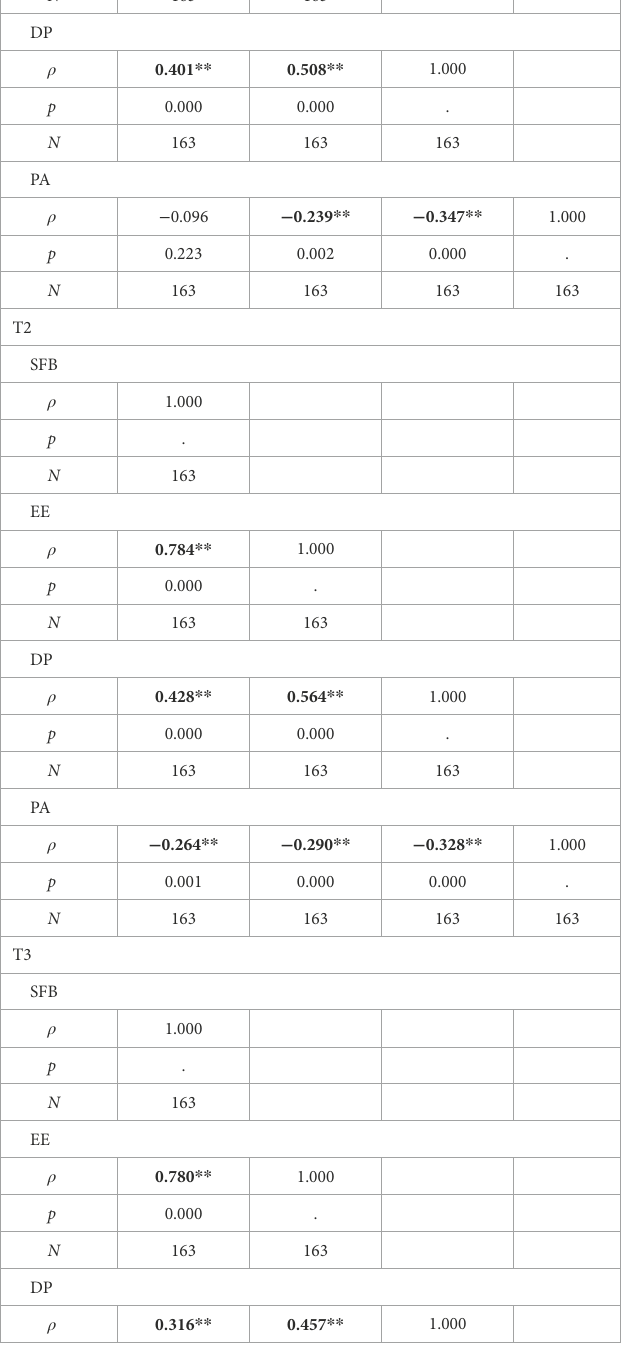
TABLE 5 Descriptive statistics and averages of burnout index comparison between gender at three time